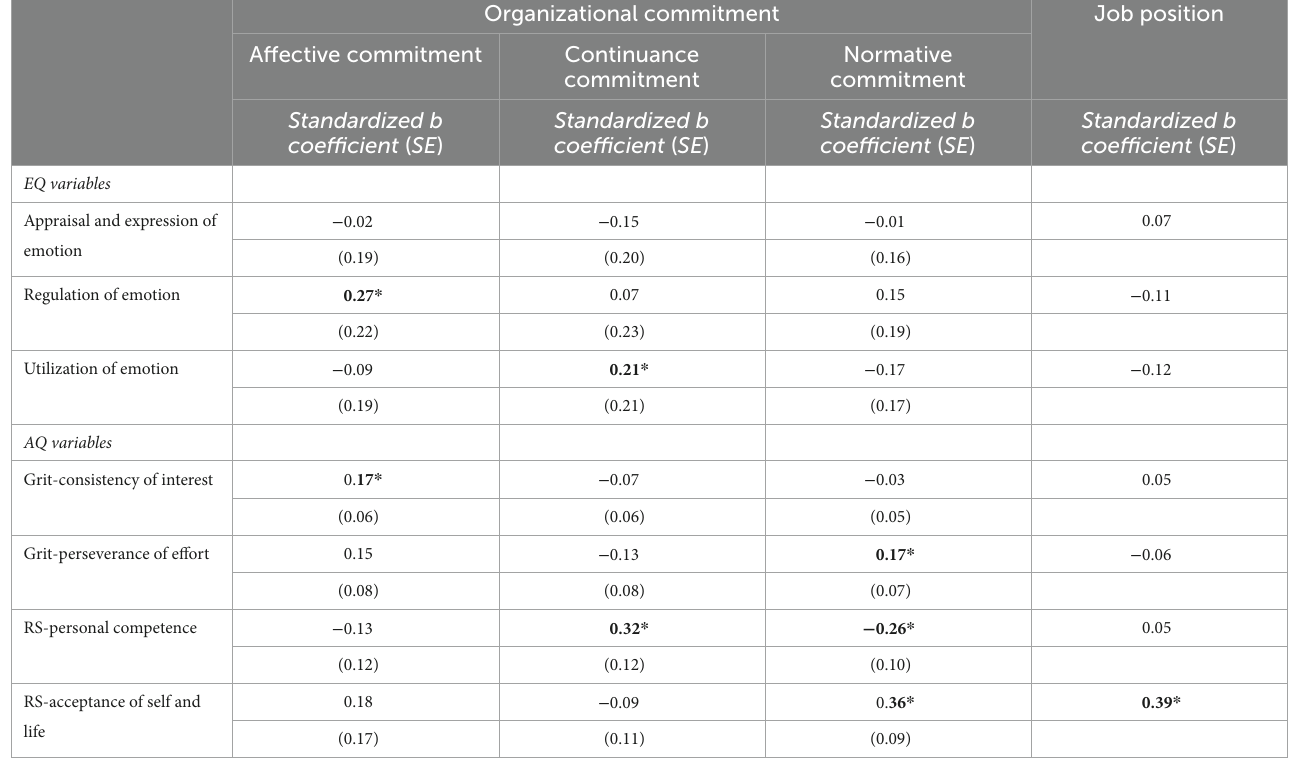
TABLE 3 Regression coefficients in predicting organizational commitment and job position from emotional quotient (EQ) and adversity quotient (AQ)